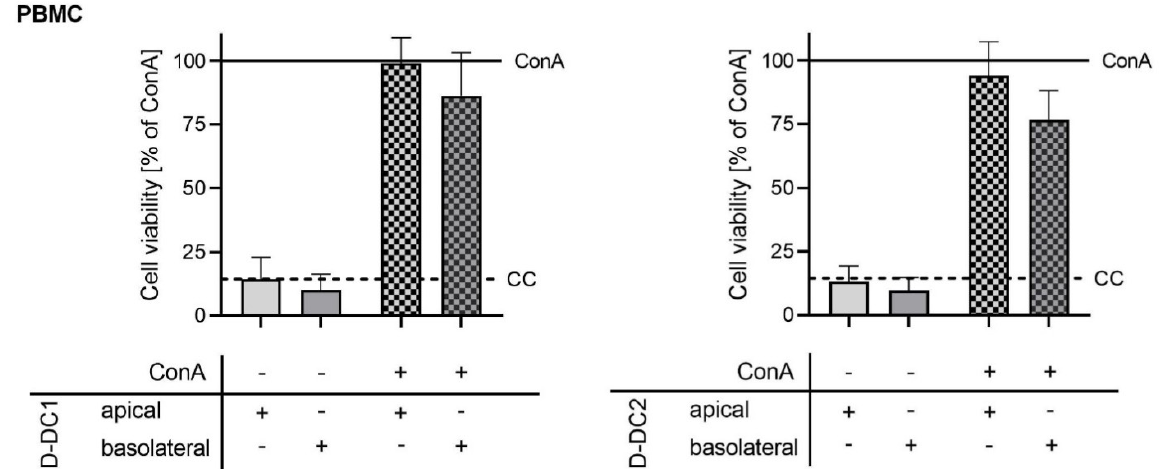
Figure 2. Effects of D-DC1 ( left ) and D-DC2 ( right ) extracts (150 µg/mL) on the viability of PBMC in the co-culture model. The viability of PBMC was determined after the conclusion of barrier integrity tests, 72 h after the application of stimuli and treatments. Bars and error bars represent the means and standard deviations of 4 independent trials (n = 4). Effects of extracts D-DC1 (on the left) and D-DC2 (on the right) without ConA-stimulation were compared statistically with the unstimulated CC (dashed line). Effects of the extracts in the presence of ConA-stimulation were compared statistically with the ConA-stimulated control (solid line, ConA), as a measure of a fully activated, stimulated PBMC population (100%).